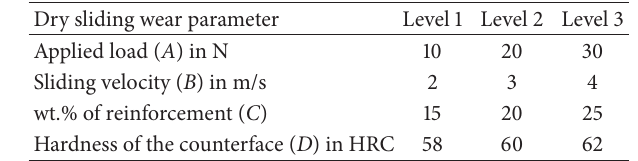
Table 5: Dry sliding wear parameters and